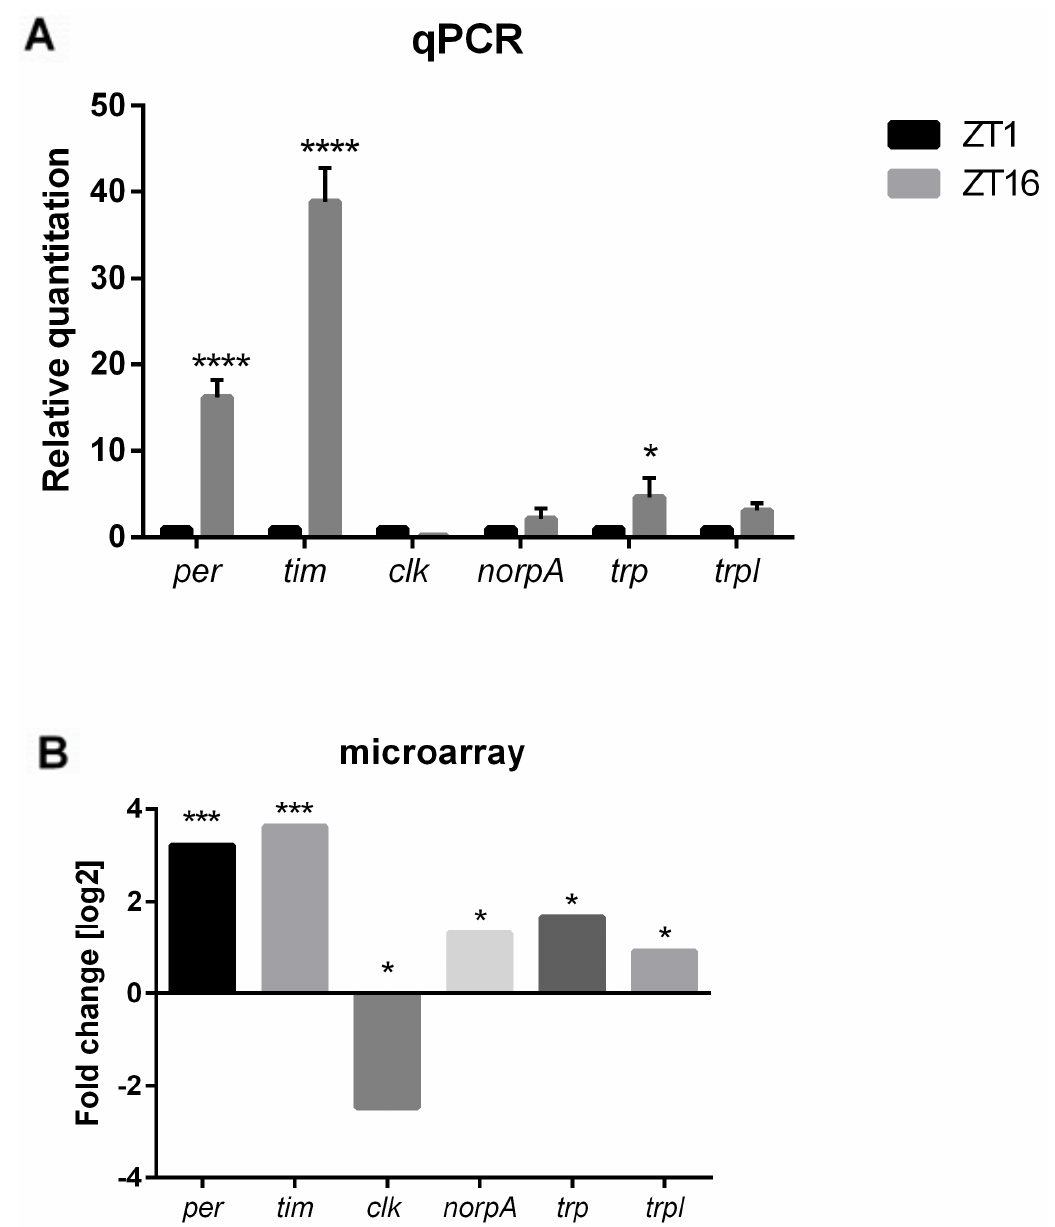
Figure 2. The comparison of microarray and qPCR data in control flies (GMR> Valium10 ) between ZT1 and ZT16. ( A ) qPCR data normalized to ZT1 as 1, statistically significant differences are marked with asterisks: * p ≤ 0.05, **** p ≤ 0.0001; ( B ) in microarray, fold change is relative to ZT1. Statistically significant changes are marked with asterisks: * 0.005 < p -values < 0.05, *** p -values < 0.0005. The pattern of gene expression, which was examined using two different techniques, is similar for the following genes: per, tim, clk, norpA, trp, and trpl.